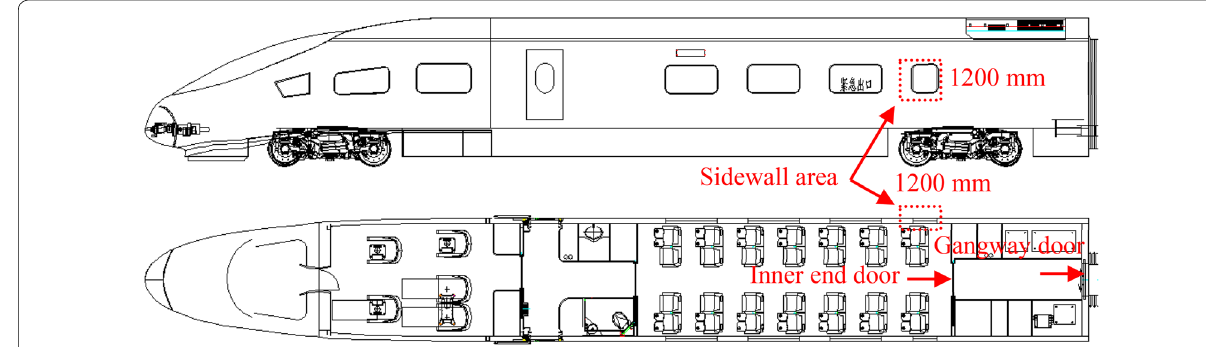
Figure 13 Test area of the sidewall of the high-speed train